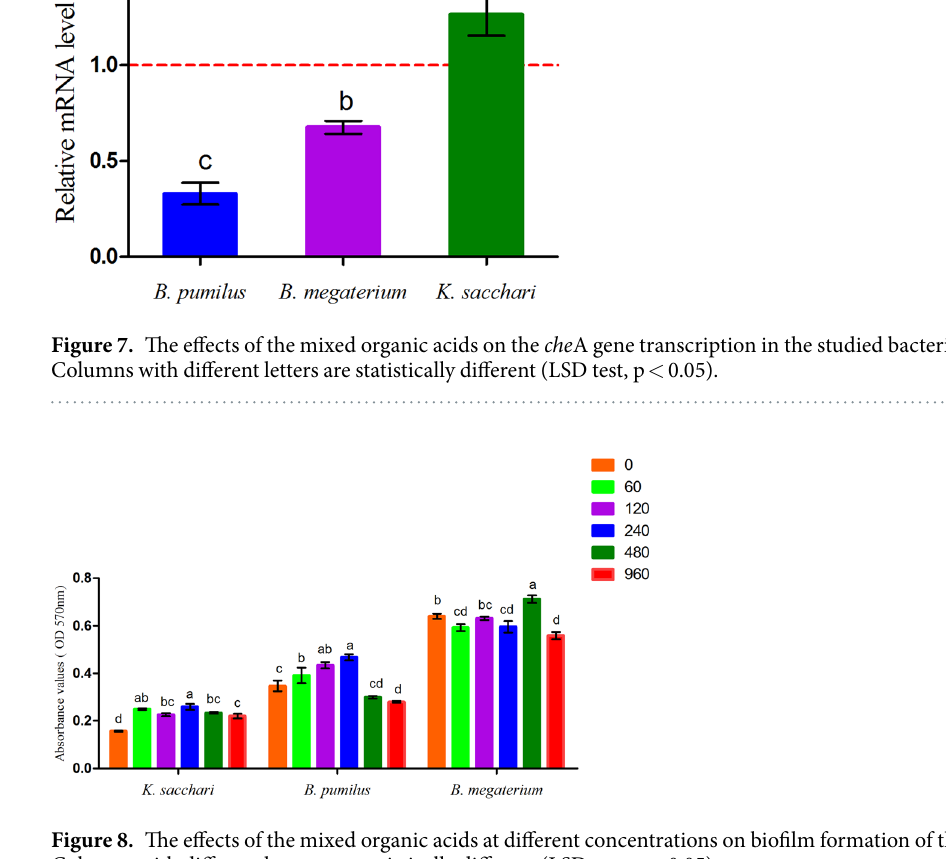
Figure 8. The effects of the mixed organic acids at different concentrations on biofilm formation of the bacteria. Columns with different letters are statistically different (LSD test, p <